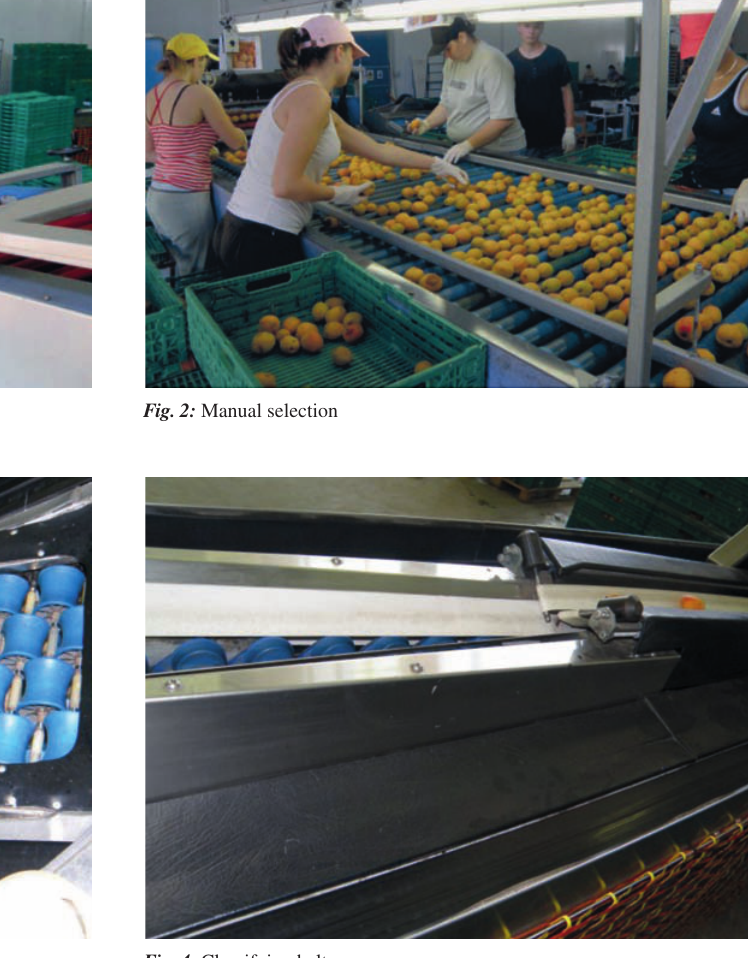
Fig. 3: Multi-line roller feeder Fig. 4: Classifying belt